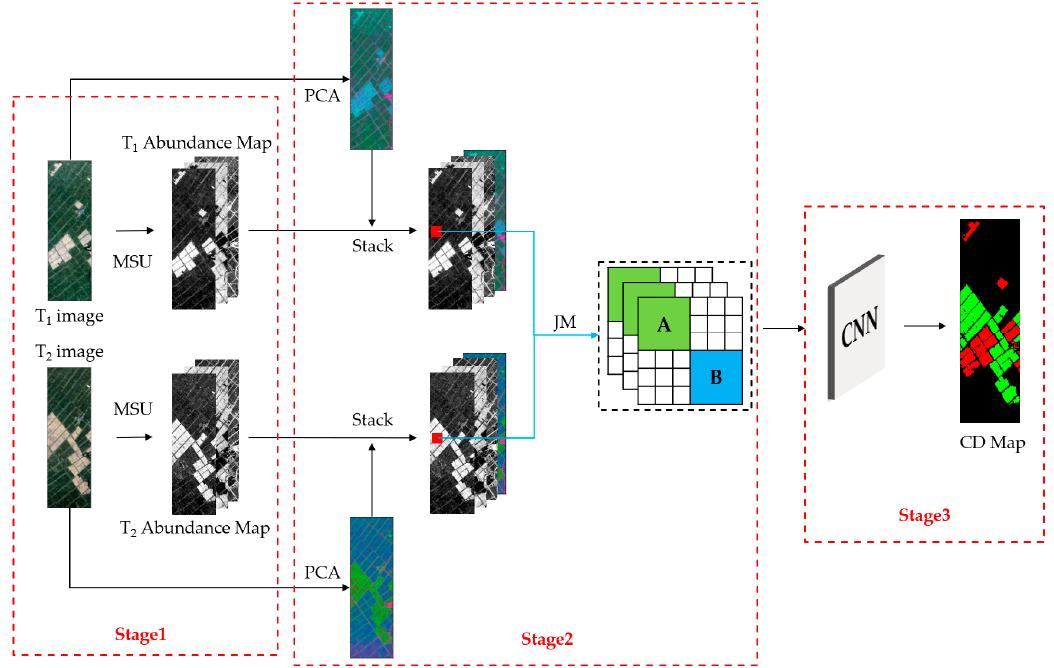
Figure 1. The architecture of the HSI-CD method based on